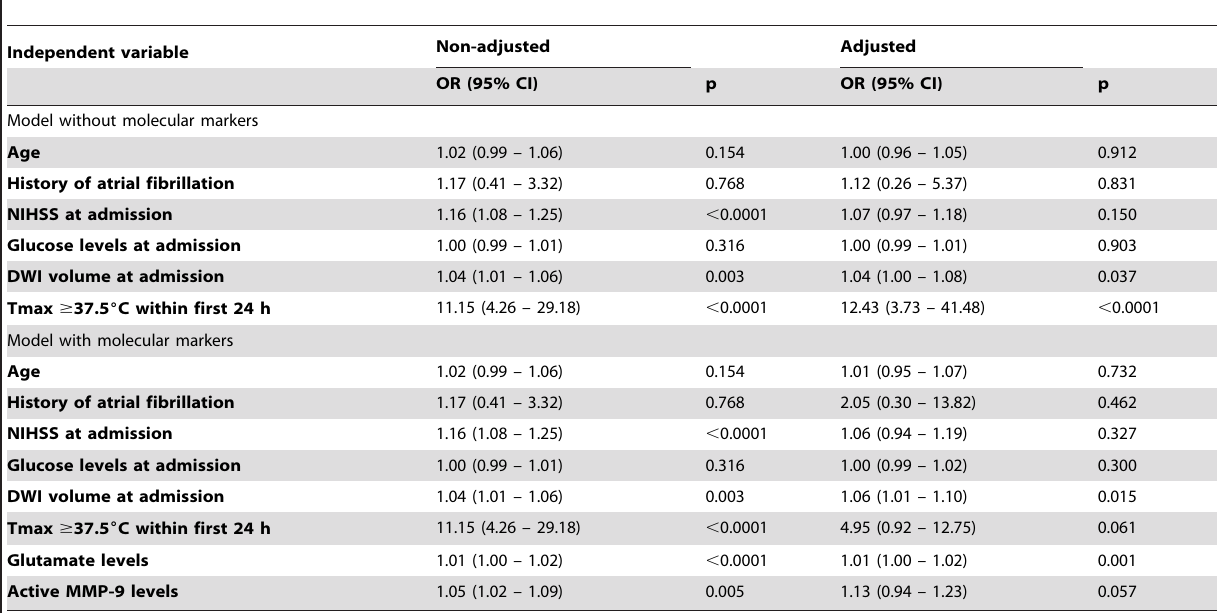
Table 2. Adjusted OR of the Tmax $ 37.5 u C within the first 24 hours and molecular markers levels for poor functional outcome at 3 months in ischemic stroke.